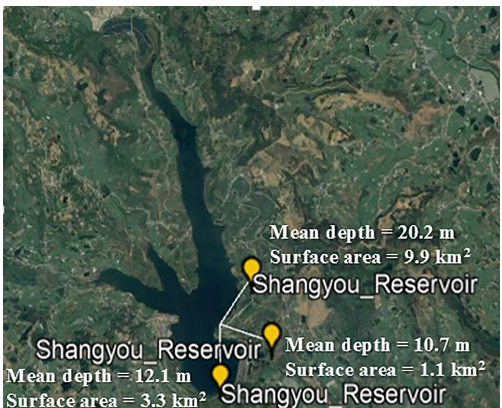
Figure 1. Duplicate example in Global Reservoir and Dam Database (GRanD). (Google Earth, https://earth.google.com/web/, last access: May